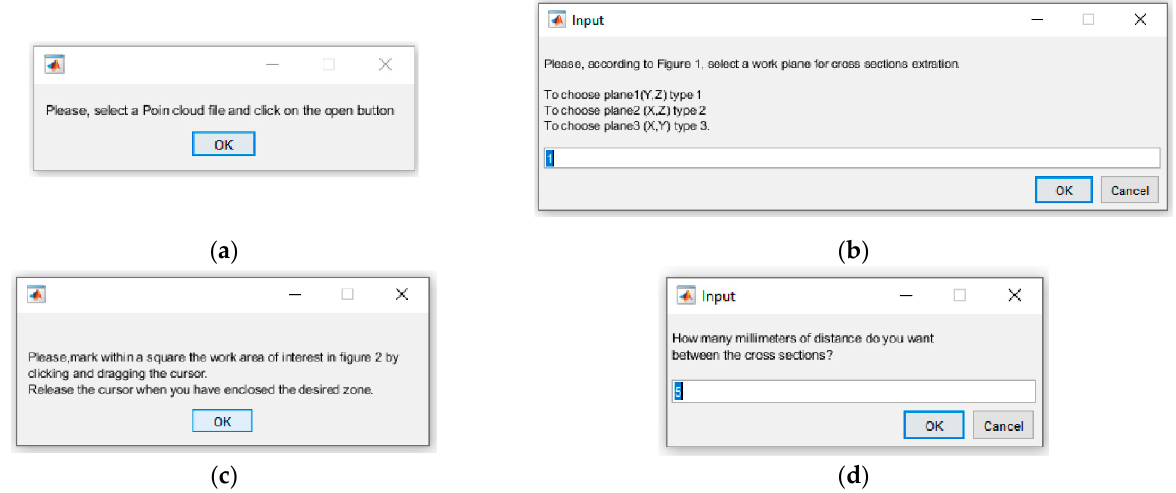
Figure 2. Screenshots of the instructions given to the user once the Matlab executable is run: ( a ) First instruction; ( b ) Second instruction; ( c ) Third instruction; ( d ) Fourth instruction.